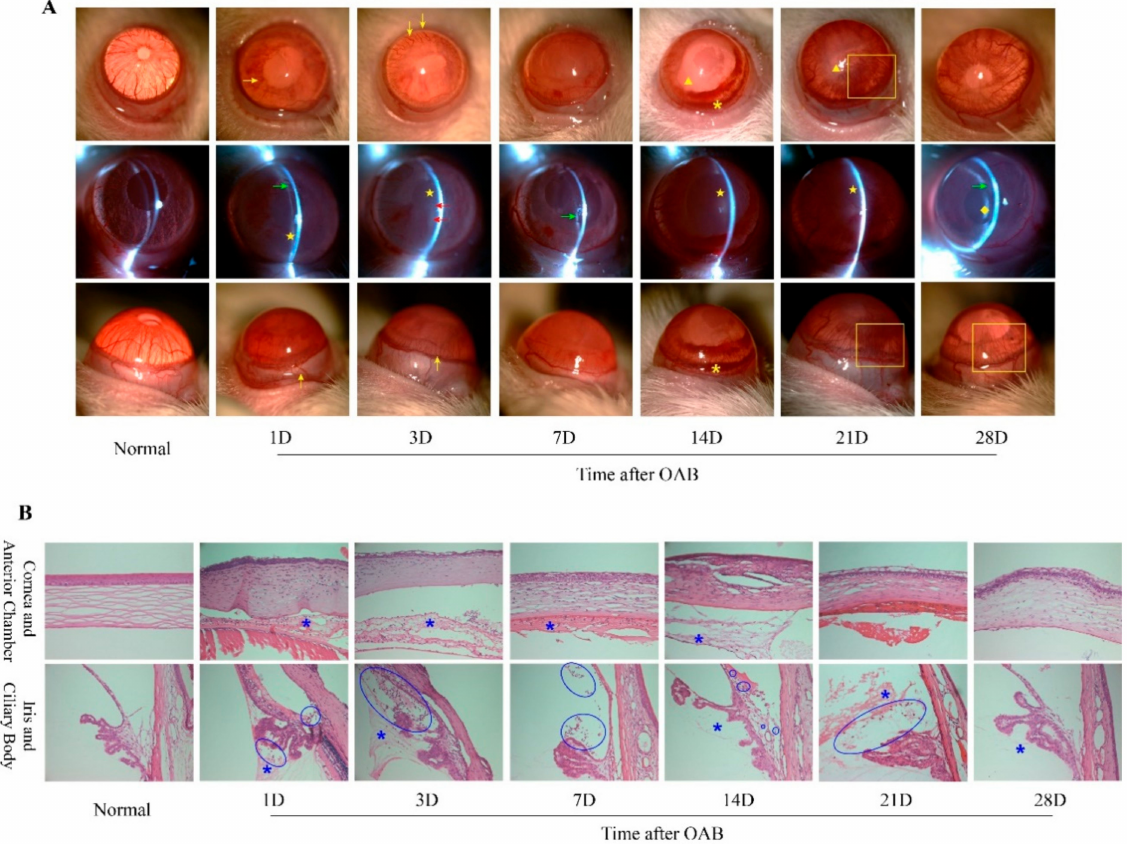
Figure 1. Slit lamp photographs and H and E staining of the anterior segment of the normal control and OAB-subjected eyes ( n = 6 for each time point). ( A ): Slit lamp photographs of the anterior segment of the normal control and Ocular Alkali Burn (OAB-subjected eyes on the 1st, 3rd, 7th, 14th, 21st, and 28th day post-modeling. Ocular hyperemia and dilated vessels (yellow → ) in the conjunctiva, limbus, and iris, aqueous flare (yellow (cid:70) ), anterior cells (red → ), fibrin exudation (green → ), posterior synechia and irregular pupil (yellow (cid:78) ), anterior chamber hyphema (yellow *), corneal neovascularization (yellow (cid:3) ), fibrin membrane, and complicated cataracts (yellow (cid:117) ) were observed at different timepoints. ( B ): Histopathological slices with H&E staining of the anterior segment of normal control and OAB-subjected eyes at each timepoint. Inflammatory cells were not detected in the cornea, iris, anterior, or posterior chambers in the normal control eye(s). Various immune cells (blue ) and fibrin exudation (blue *) were observed in the anterior segment from days 1 to 21. On (cid:35) the 28th day, immune cells were not found, but fibrin exudation